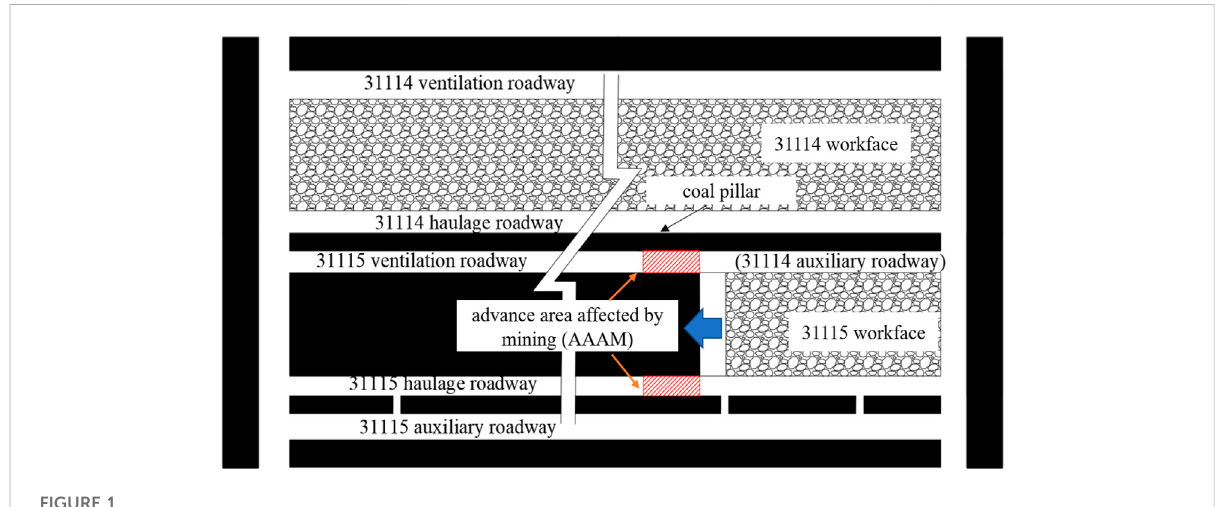
FIGURE 1 Roadway layout of the working face.